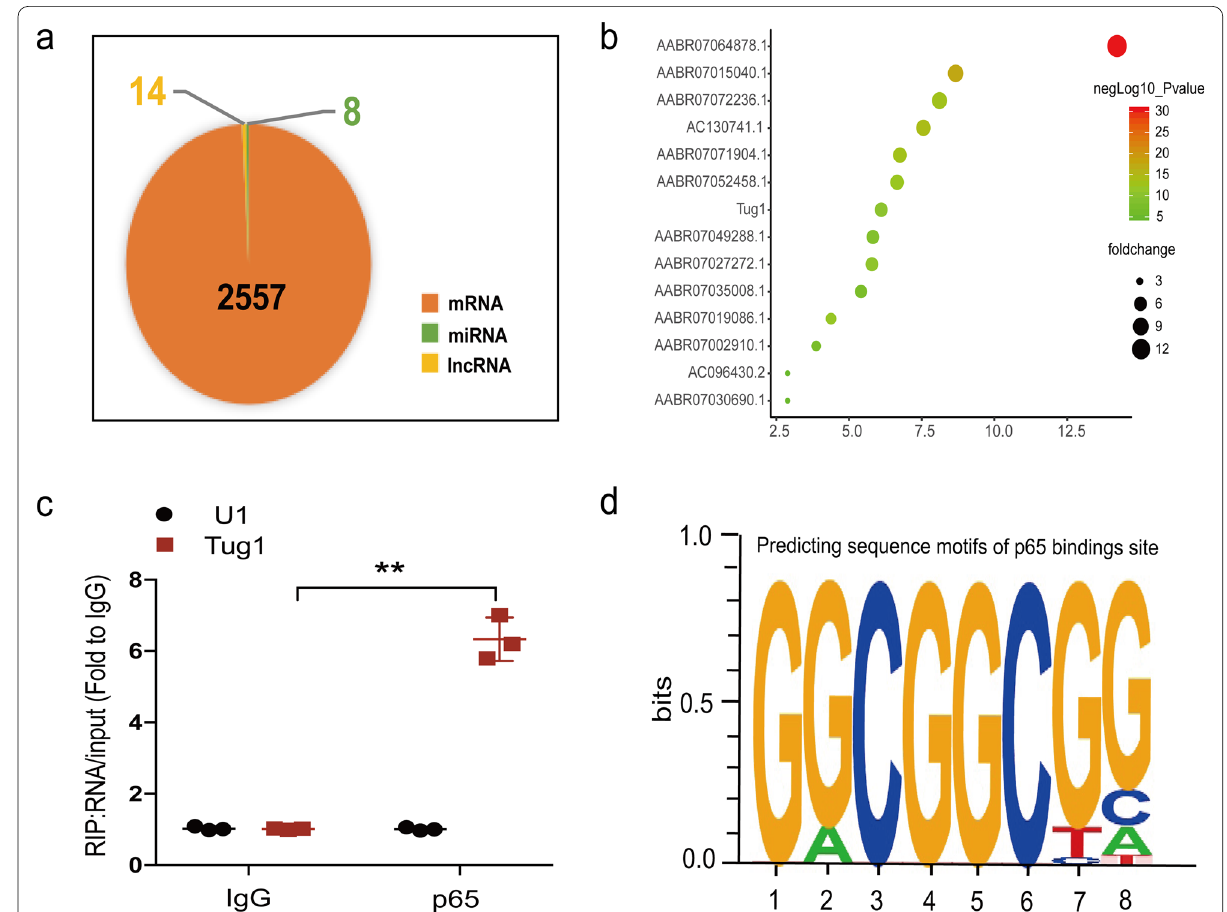
Fig. 1 The data of RIP sequencing in microglia. a The number of RNAs binding to the NF-κB p65 in microglia. b The bubble diagram of long non-coding RNAs binding to the NF-κB p65 protein. c RIP assays of Tug1 in microglia. d POSTAR2 was used to predict the sequence motifs of p65-binding sites. Student’s t test was used (** P < 0.01 vs.